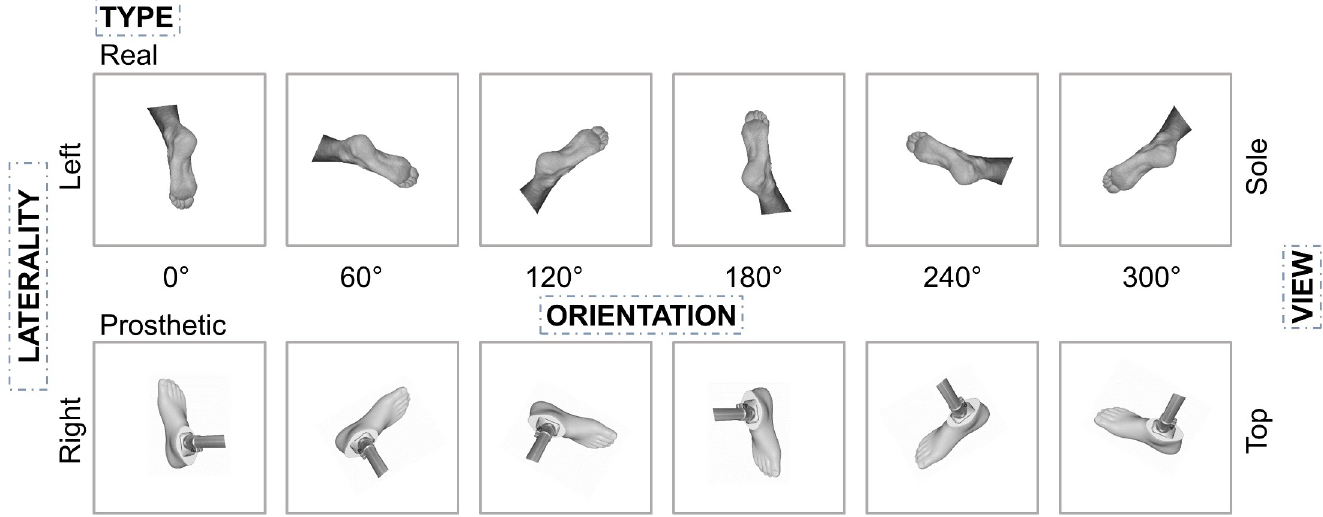
Fig 1. Example of stimuli used in mental rotation task. The image is a visualization of a portion of the stimuli used in the mental rotation task. Note that real feet were also presented from the top view with right laterality in all orientations. Likewise, prosthetic feet were also presented from the sole view with left laterality in all orientations. Use of these stimuli yielded a 6 (orientation) x 2 (side) x 2 (type) x 2 (view) design.